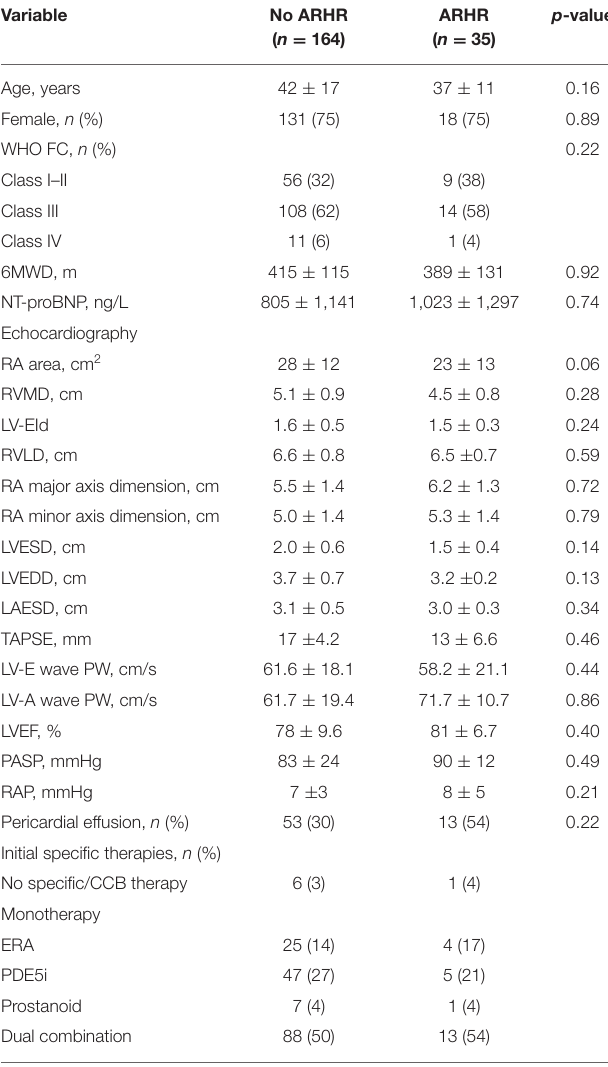
death. Model 2 was created by adding the echo score